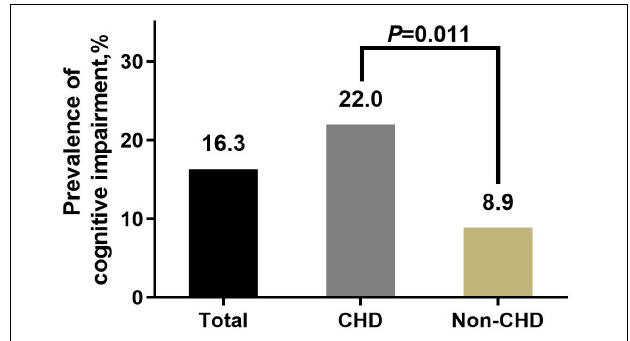
FIGURE 2 | Prevalence of cognitive impairment according to CHD. CHD, coronary heart disease.